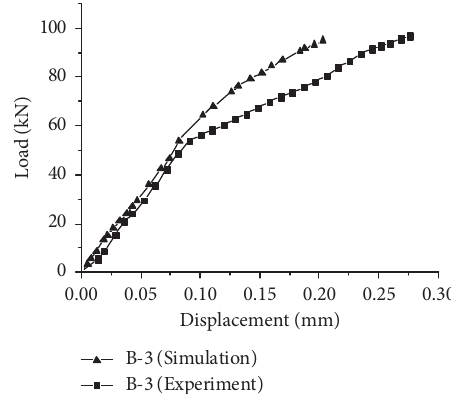
Figure 6: Comparison diagram of displacement load curve of B-3.